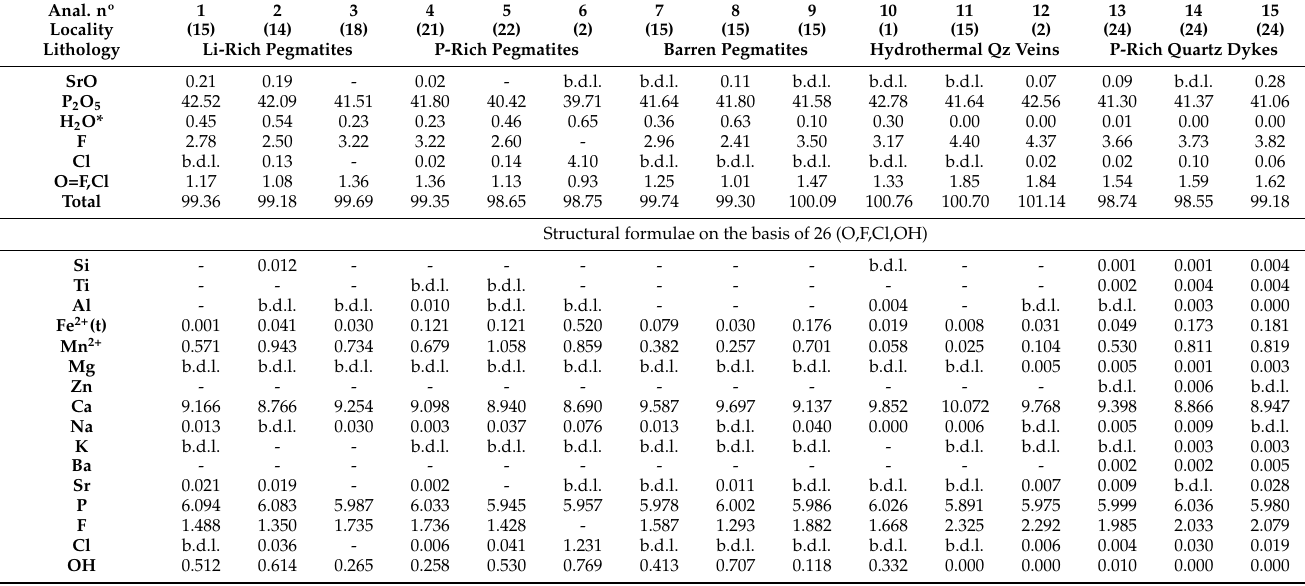
Table 4. Representative microprobe analyses with major element composition (wt.%) and unit for- mula (a.p.f.u.) calculated on the basis of 26 (O,F,Cl,OH), H 2 O* estimated, for apatite associated with the different units distinguished in the Puentemocha pegmatite and in its hosting granite. b.d.l. be- low detection limit. — not analyzed.